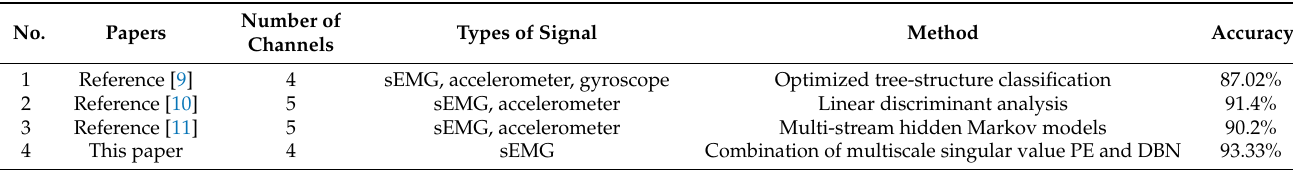
Figure 1. Framework of gesture recognition method. Table 1. Description of comparison of methods.